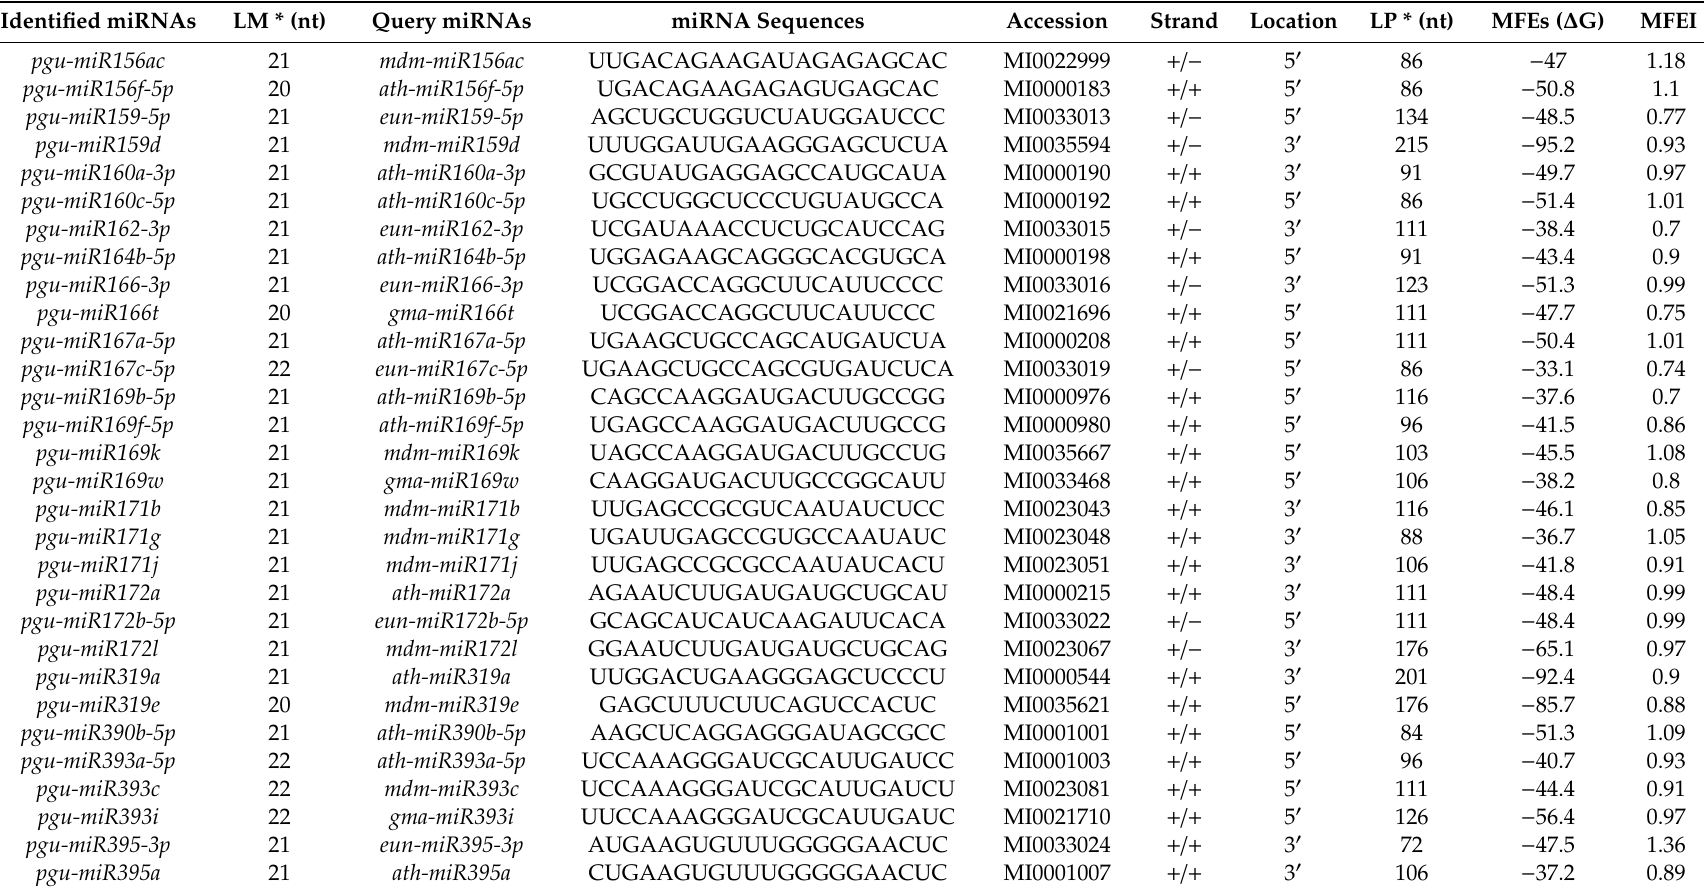
Table 1. Potential miRNAs in